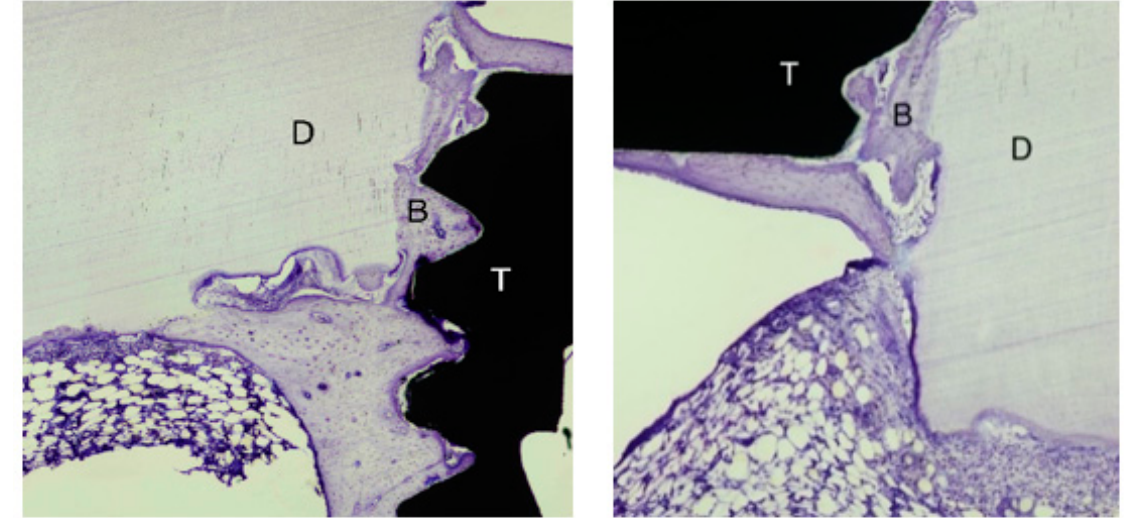
Figure 6. Representative histological sections showing migration of the newly formed bone ( B ) into the spaces between the dentin fragment ( D ) and the titanium surface ( T ). Toluidine blue stain; 4× magnification.